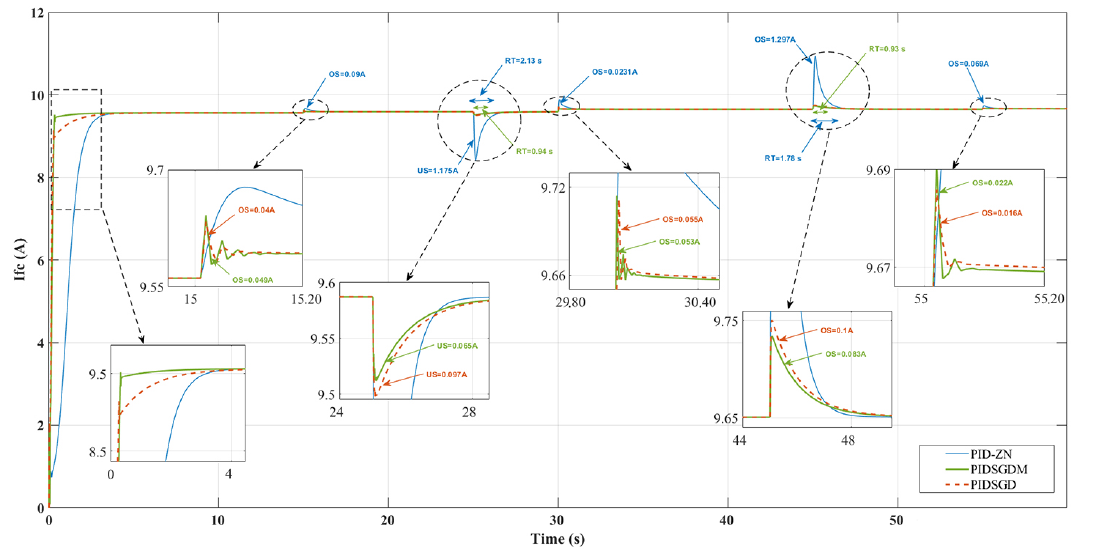
Figure 11. PEMFC stack output current.